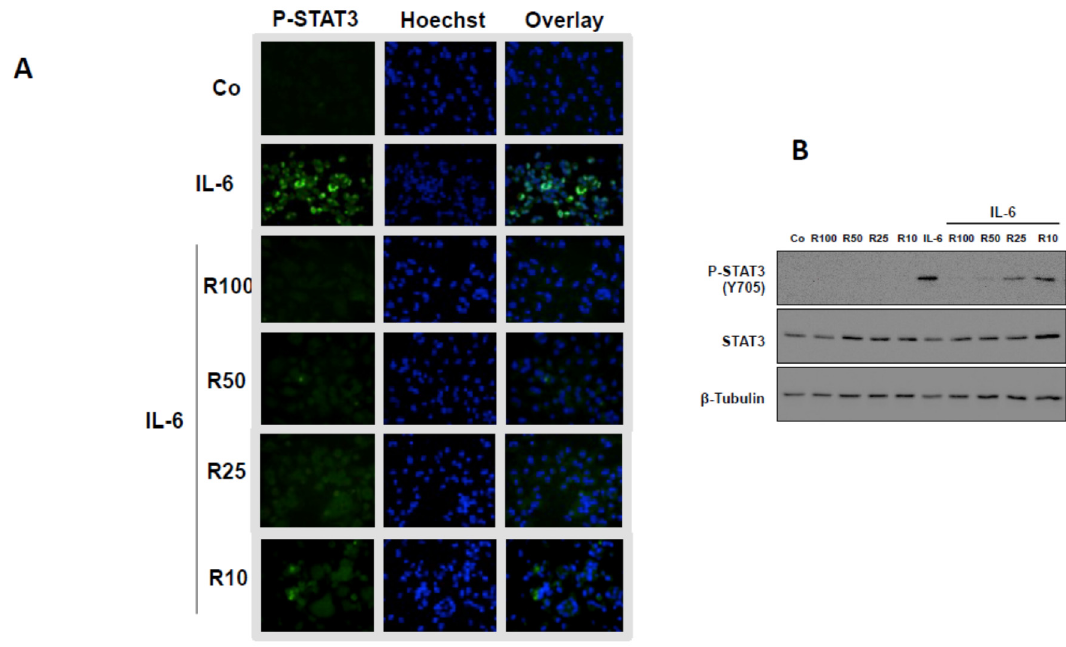
Figure 5. Resveratrol effects on the levels of STAT3 phosphorylation in macrophage monoculture. ( A ) Fluorescence microscopy analysis of STAT3 phosphorylation (green labeling). Resveratrol (100 or 50, 25 or 10 μ M) limits the IL ‐ 6 ‐ induced STAT3 phosphorylation level (decrease of green labeling). Cell nuclei were labeled with Hoechst dye. The overlay confirms the nuclear location of p ‐ STAT3. Representative data from one of three experiments are shown; ( B ) Western blotting analysis of STAT3 phospholylation. Resveratrol limits the IL ‐ 1 β‐ induced STAT3 phospholylation. β‐ Tubulin: protein loading control; Co, control. Representative data from one of three experiments are shown.